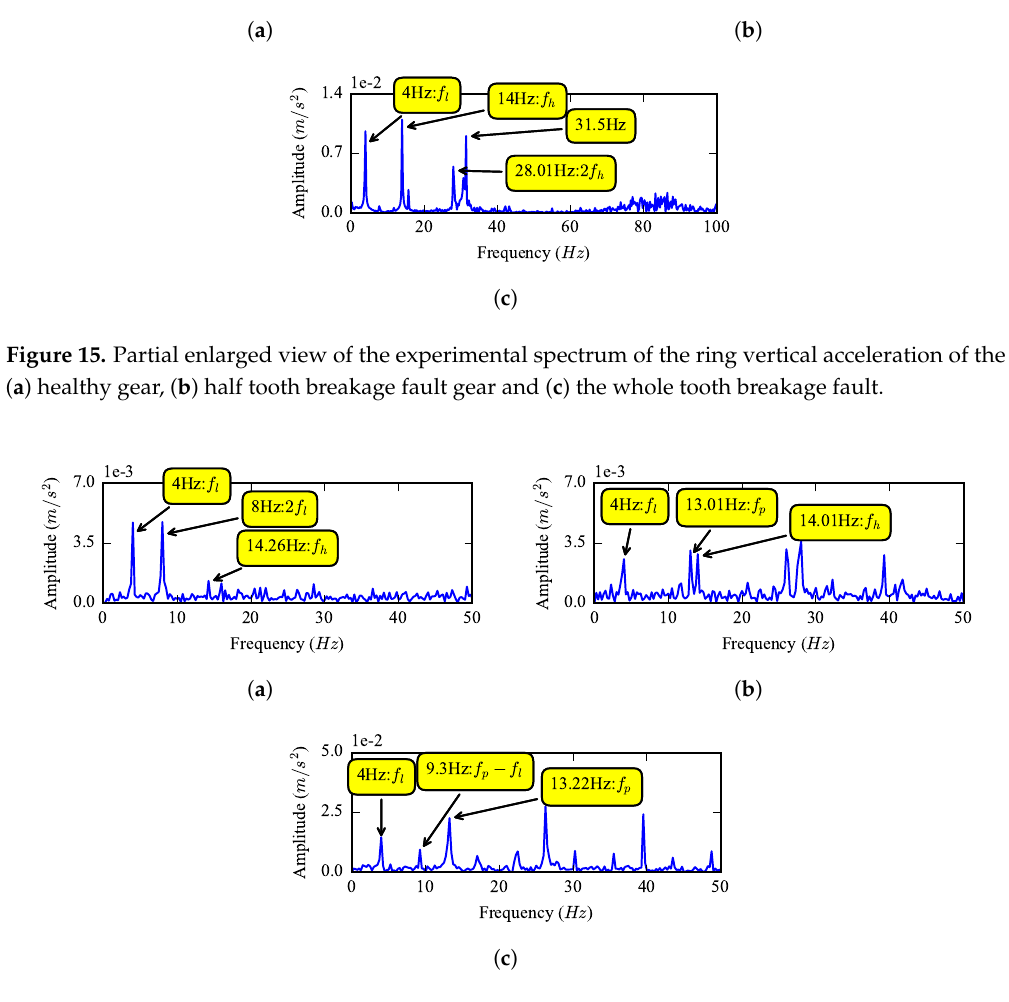
Figure 16. Envelope spectrum of the experimental ring vertical acceleration of the ( a ) healthy gear, ( b ) half tooth breakage fault gear and ( c ) the whole tooth breakage fault. Table 4. Parameters of the planetary